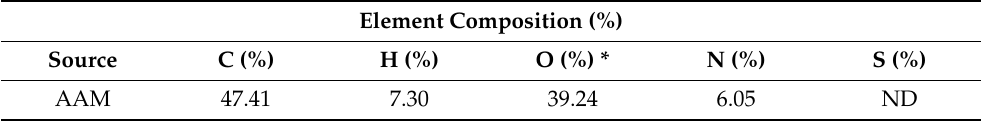
Table 2. Elemental composition of A. auricula